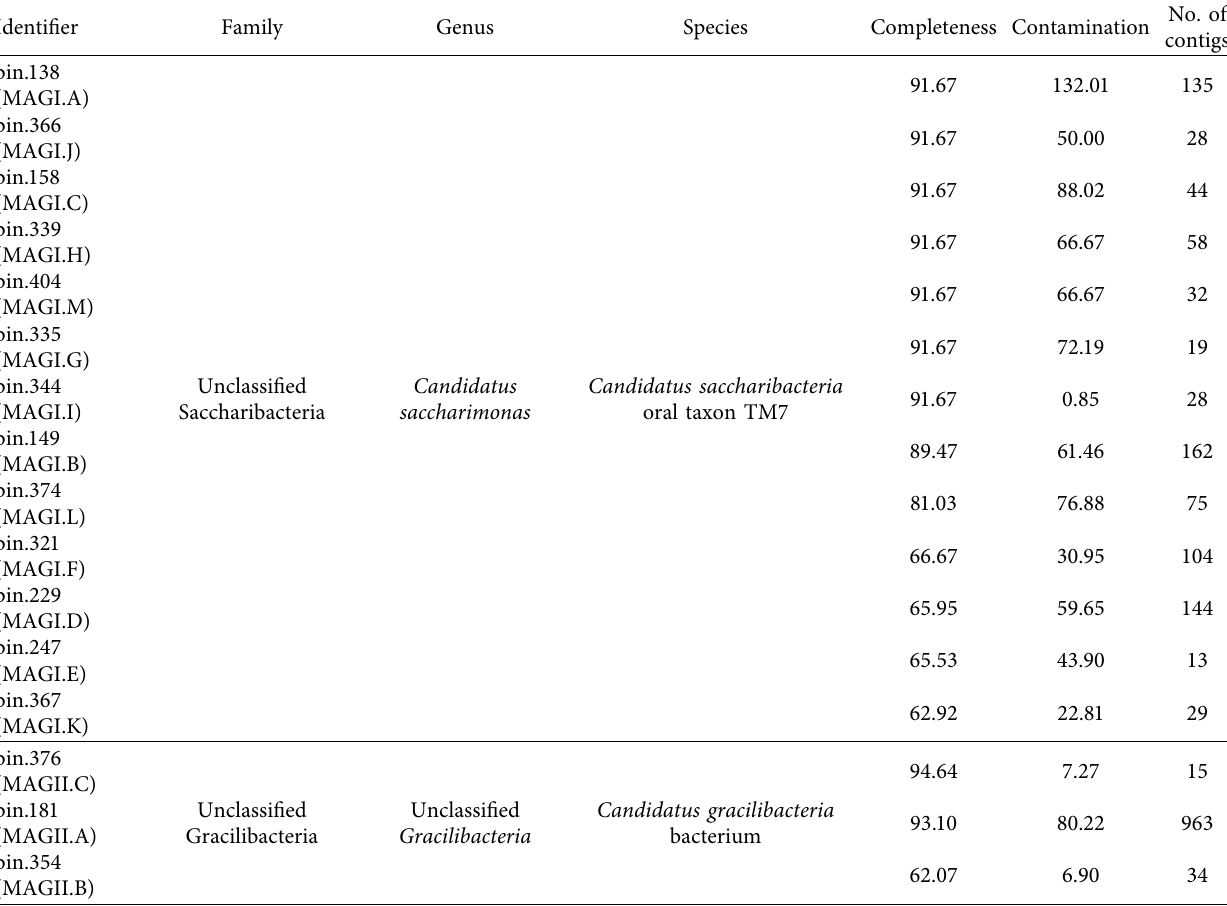
Table 1: Basic information about CPR